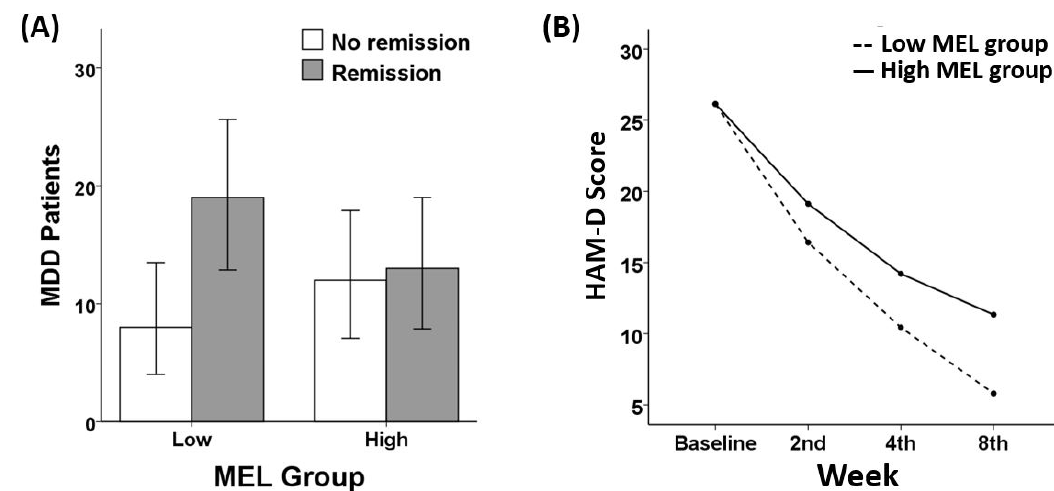
Figure 4. ( A ) Remission ratio by melancholic (MEL) groups (chi-square = 1.851, p = 0.174) and ( B ) treatment responsiveness in HAM-D score over the eight weeks by Low and High MEL groups (rANOVA: F (2.548, 117.185) = 2.474, p = 0.075).